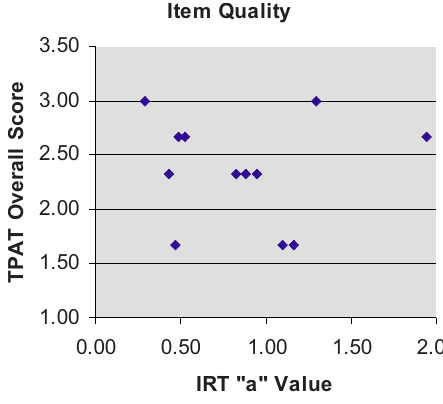
FIG. 3. (cid:1) Color (cid:2) TPAT expert ratings plotted against the IRT “ a ” (cid:1) discrimination (cid:2) parameter for the physics items from the 2004